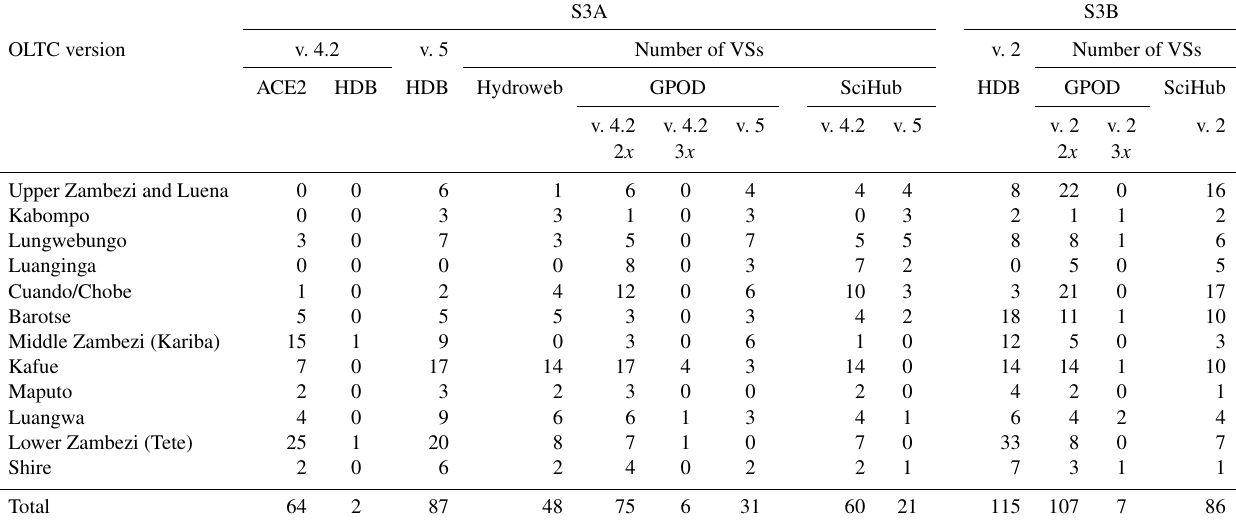
Table 4. Open-Loop Tracking Command (OLTC) targets before and after March 2019 for the Zambezi catchment and their source (ACE-2 – global DEM or hydrology databases, HDBs). The targets are obtained from https://www.altimetry-hydro.eu/ (last access: 15 January 2021). The Hydroweb Theia S3A virtual stations (VSs) within each watershed are available at http://hydroweb.theia-land.fr/ (last access: 15 Jan- uary 2021). The VSs are grouped by major watersheds and according to the processing setting required. The versions indicate the OLTC version after which useful water surface elevation observations could be retrieved at the VSs. The total sums correspond to the values in Table 3.